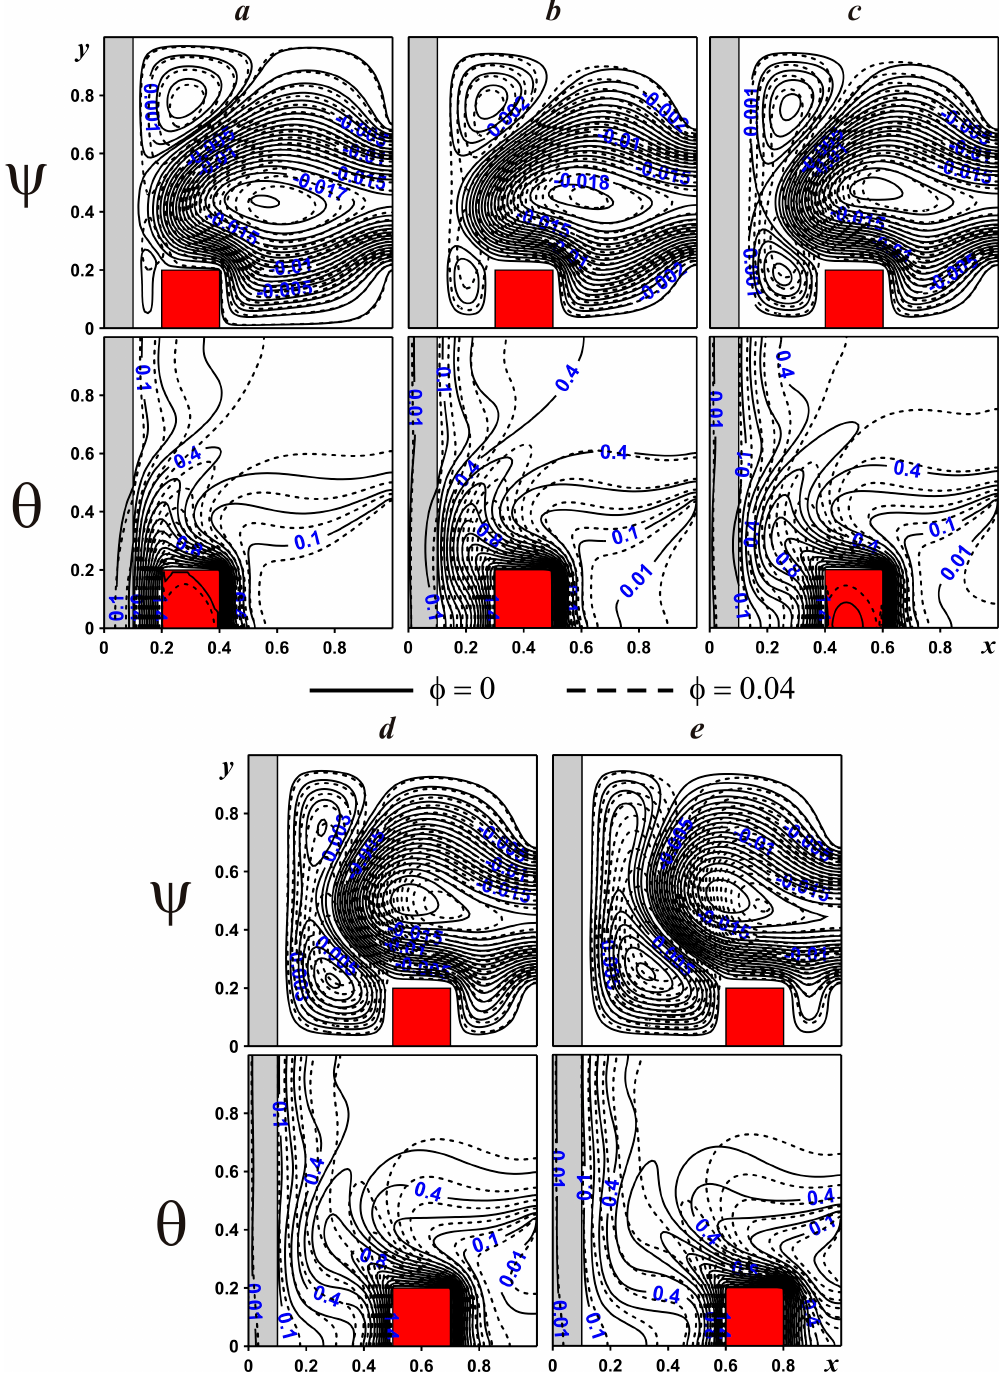
Figure 9. Streamlines ψ and isotherms θ for Ra = 10 5 , K r = 5: δ = 0.1 ( a ), δ = 0.2 ( b ), δ = 0.3 ( c ), δ = 0.4 ( d ), δ = 0.5 ( e ).